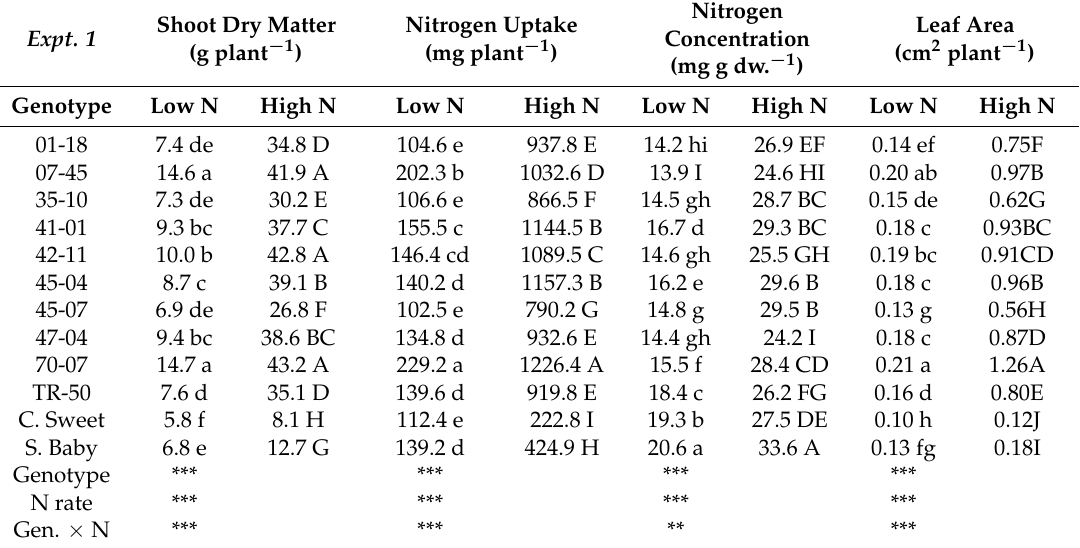
Table 1. Shoot dry matter, nitrogen uptake, nitrogen concentration and total leaf area of ten bottle gourd genotypes and two watermelon cultivars grown under low (0.3 mM) and high (3.0 mM) N supply in Expt. 1